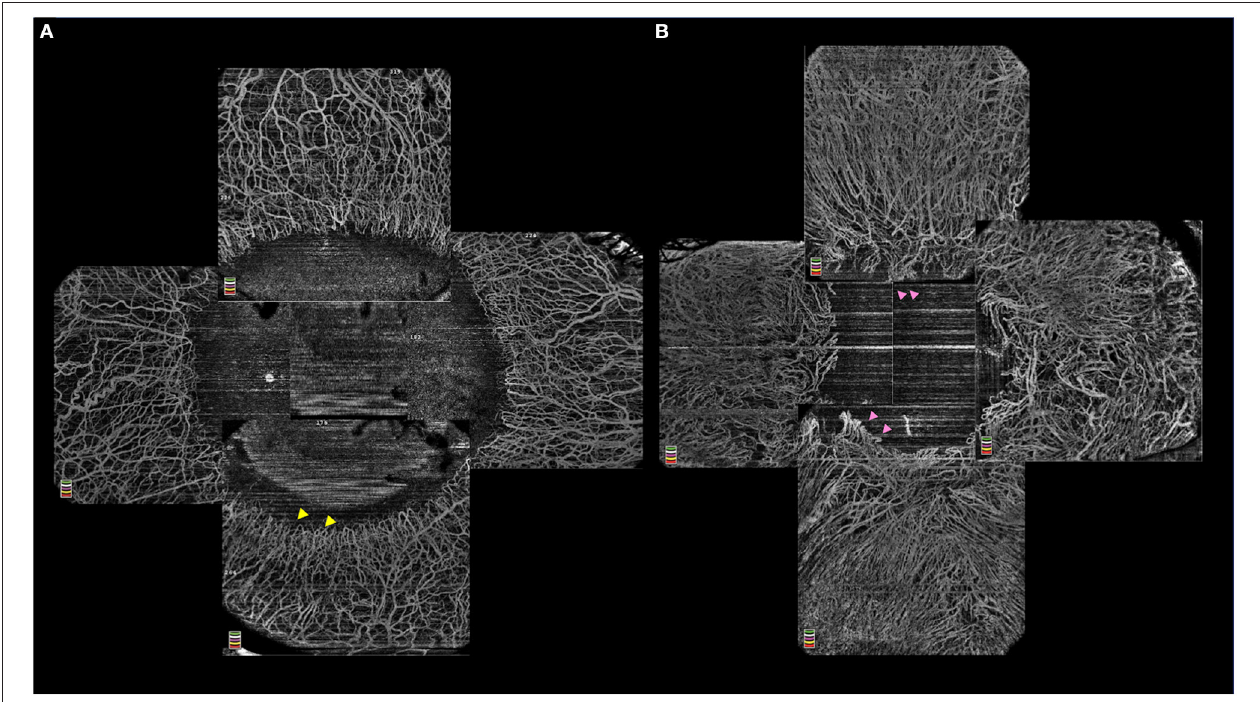
FIGURE 4 | (A) Optical coherence tomography-angiography (OCT-A) illustrating a normal limbal vasculature with hairpin looped limbal vessels (yellow arrowheads) and surrounding normal perilimbal conjunctival and episcleral vessels. (B) OCT-A in in limbal stem cell deficiency with vascular invasion of the peripheral corneal and distortion of the annular ring of hairpin looped limbal vessels (pink